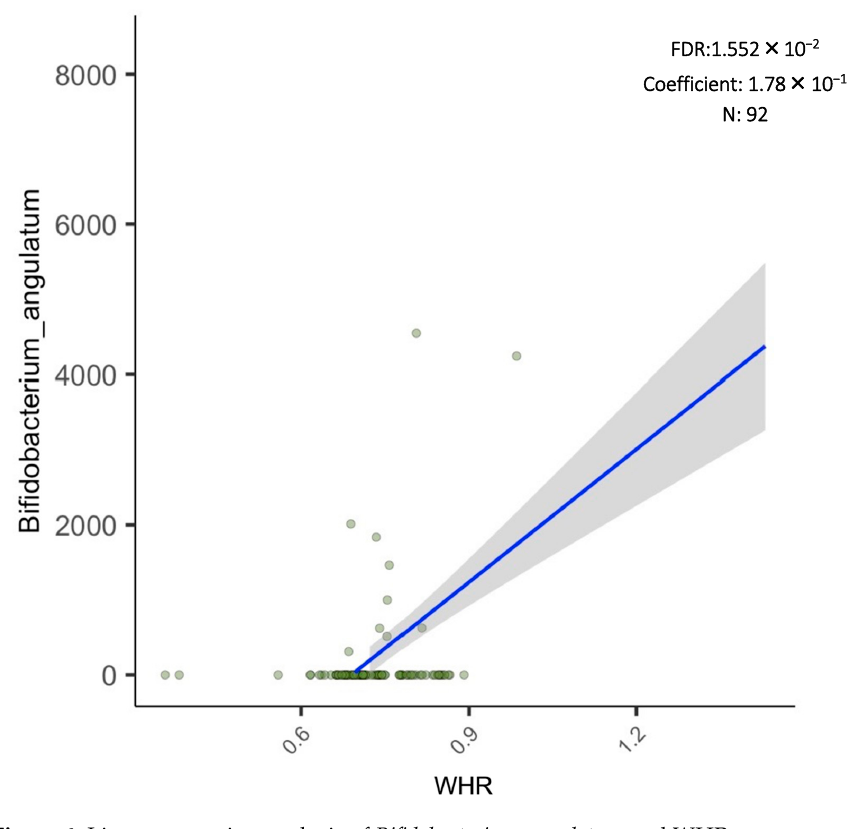
Figure 6. Linear regression analysis of Bifidobacterium angulatum and WHR.